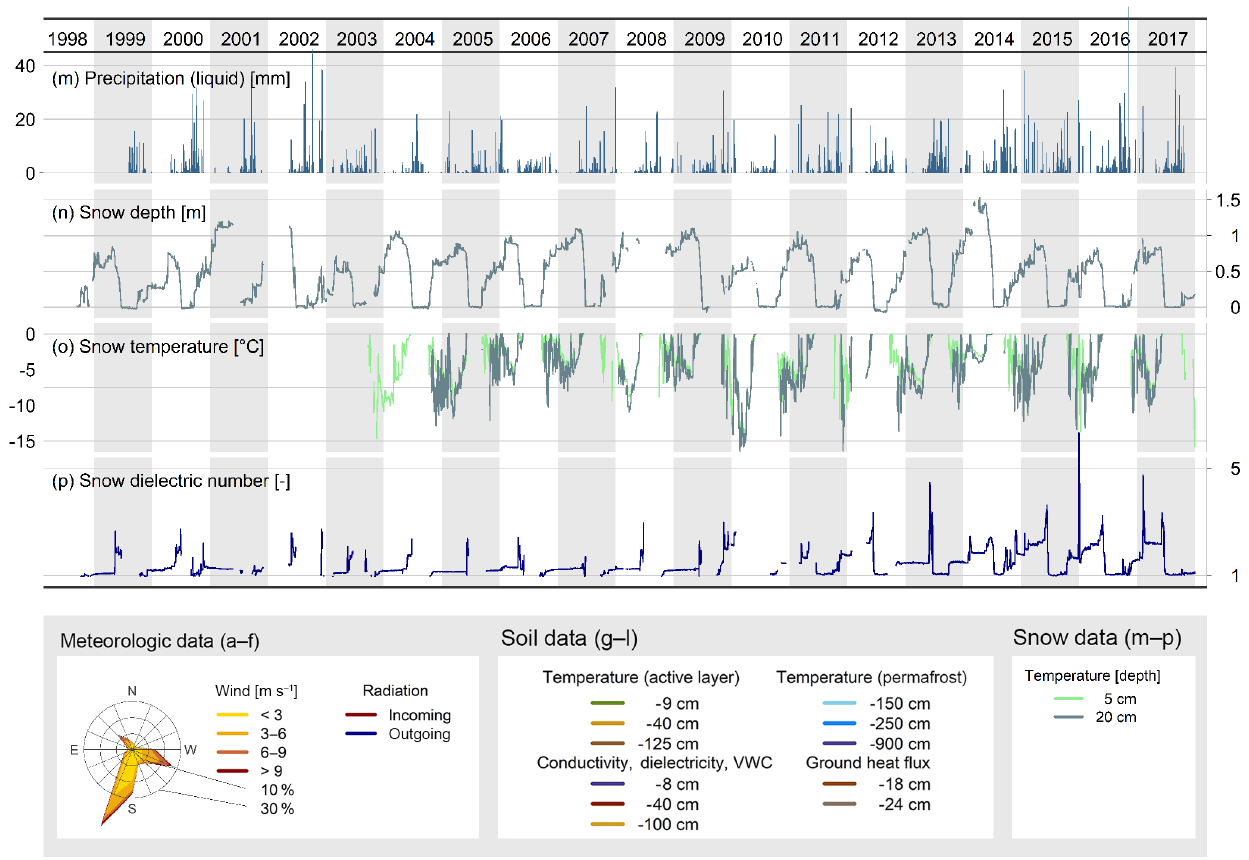
Figure H1. Time series of Bayelva data provided in this paper (Fig. 3) divided into three plots. (a–f) Meteorological data; (g–l) soil and subsurface data; (m–p) snow data. The data are organized following the structure of Appendix G. Further details on the sensors and periods of operation are given in Table